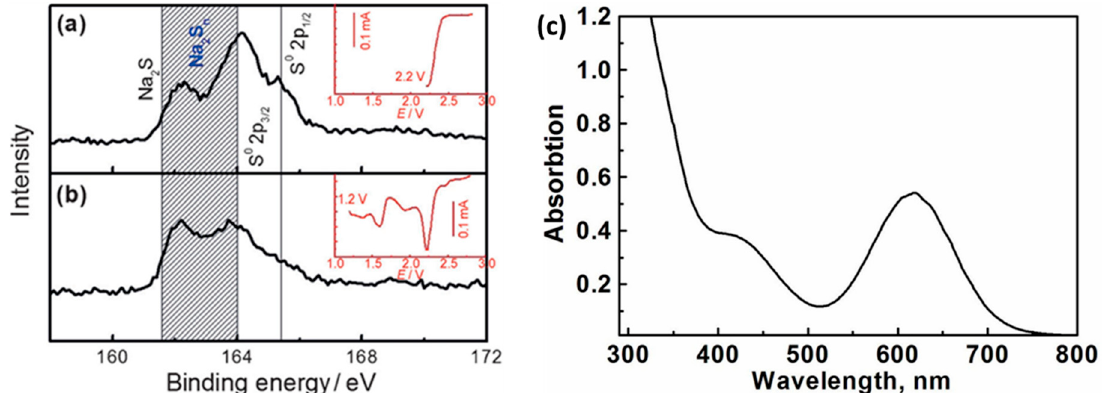
Figure 3. High-resolution S2p XPS spectra of the sulfur cathode being discharged to ( a ) 2.2 and ( b ) 1.2 V at a scan rate of 0.1 mVs -1 . Insets are the voltammogram profiles of each electrode. ( c ) UV-Vis absorption spectra of the discharge product of the sulfur cathode that was discharged to 1.8 V.